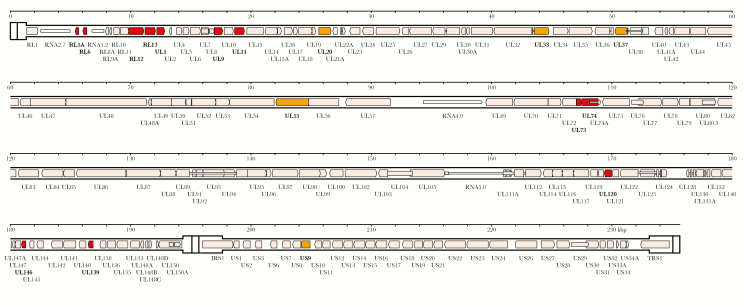
Locations in the human cytomegalovirus strain Merlin genome of genes used for genotyping. The genome consists of 2 unique regions, UL (1325–194 343 bp) and US (197 627–233 108 bp), the former flanked by inverted repeats TRL (1–1324 bp) and IRL (194 344–195 667 bp), and the latter flanked by inverted repeats IRS (195 090–197 626 bp) and TRS (233 109–235 646 bp). Protein-coding regions are indicated by shaded arrows, and noncoding RNAs as narrower, white arrows, with gene nomenclature below. Introns are shown as narrow white bars. The 12 genes (RL5A, RL6, RL12, RL13, UL1, UL9, UL11, UL73, UL74, UL120, UL146, and UL139) used for motif read-matching are in dark gray (red in online version). Two of these genes (RL13 and UL146) were also used for genotype read-matching. The additional 5 genes (UL20, UL33, UL37, UL55, and US9) used to genotype sequences by alignment are medium gray (orange in online version). All other genes are shown in white (pink in online version).